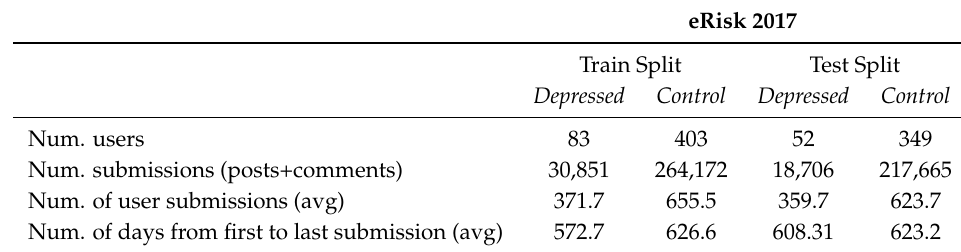
Table 1. Main statistics of the eRisk 2017 and 2018